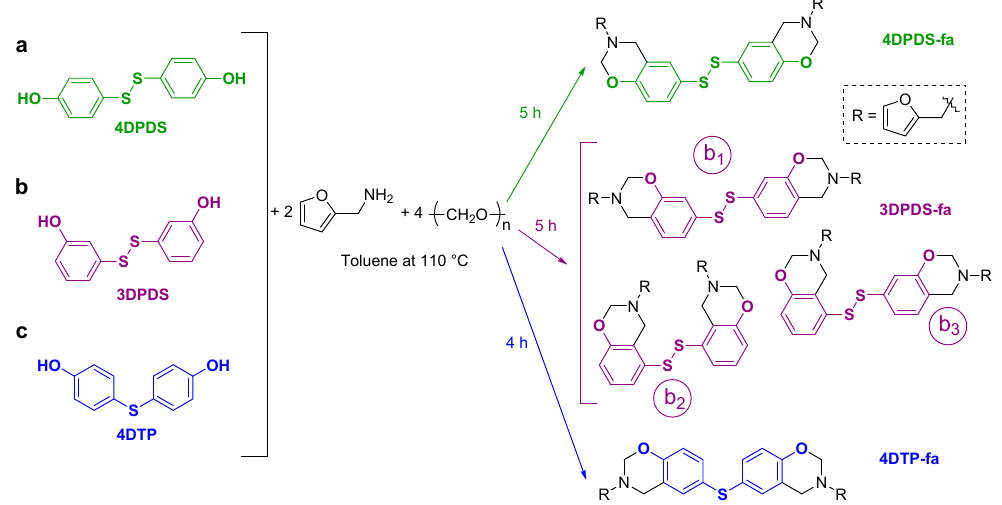
Scheme 2. Synthesis of dibenzoxazine monomers containing sulfur from diphenolic compounds: ( a ) 4DPDS, ( b ) 3DPDS, and ( c ) 4DTP; and furfurylamine.